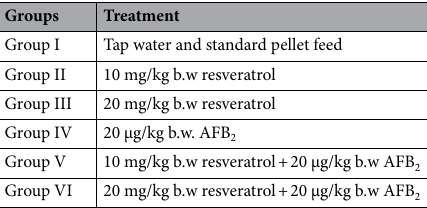
Table 1. Groups and grouping